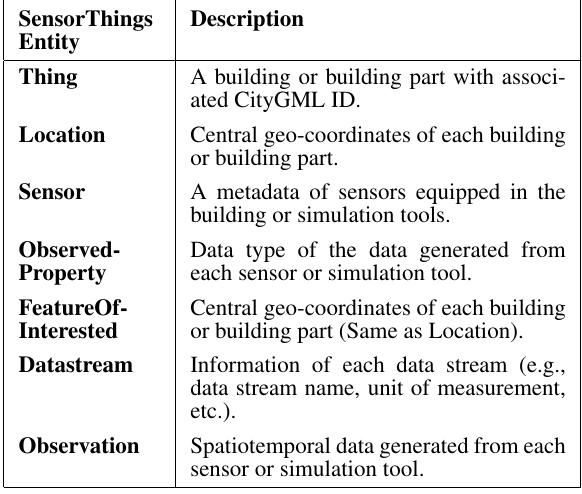
Table 2. Explanation of each SensorThings entity to store the building energy data from measured sensors and simulation tools.